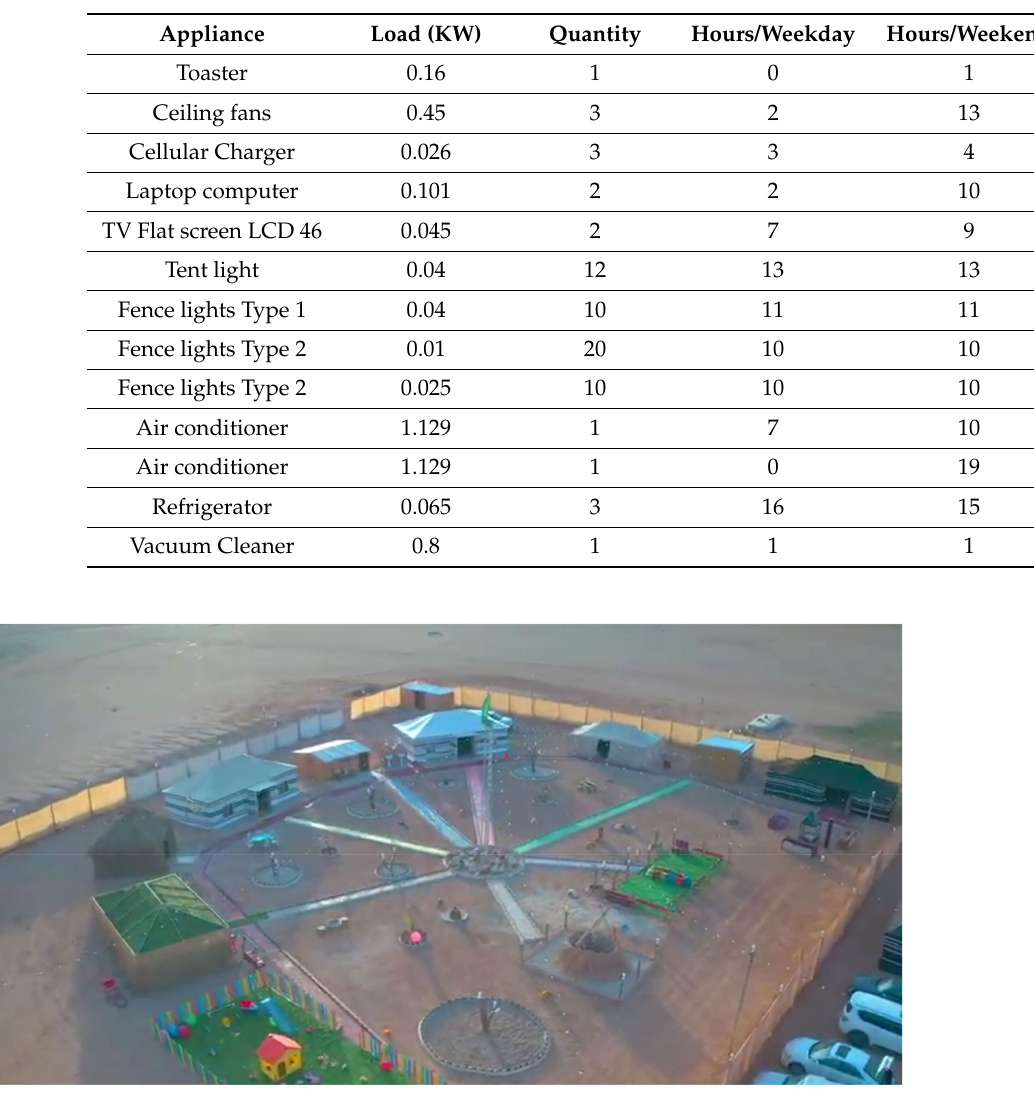
Figure 5. A typical desert camp in Hafr